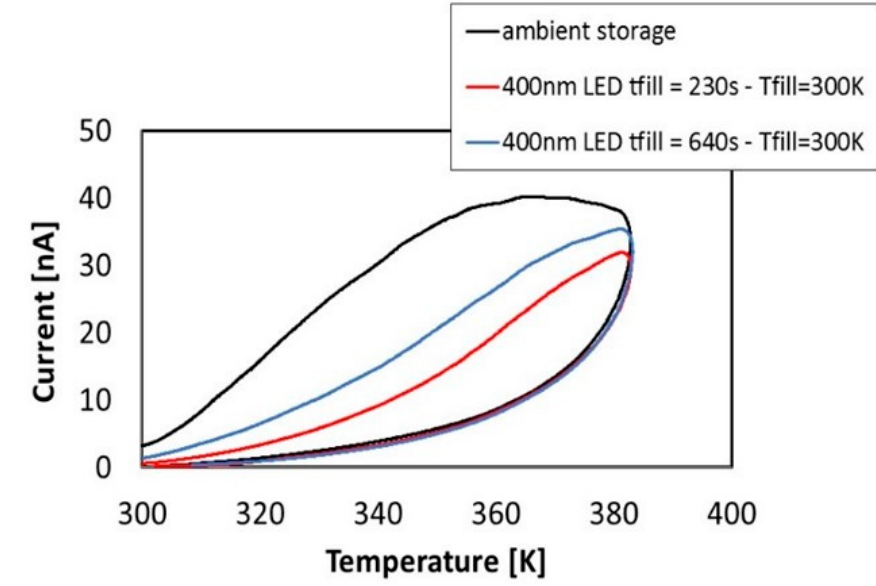
Figure 4. Thermally stimulated currents measured after the two priming processes shown in Figure 3a as compared with the one measured with the same sample after storage in ambient light, same T i = 300 K, V b = 5 V and heating and cooling rate β = 0.08 K / s.